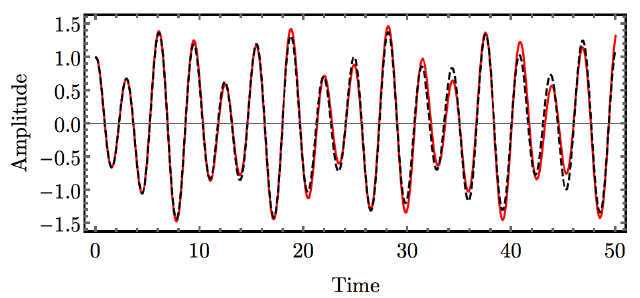
Figure 8. The red curve is the numerical solution and the dashed blue curve is the MDTM solution by Padé approximant [6/6] in Equation (41).